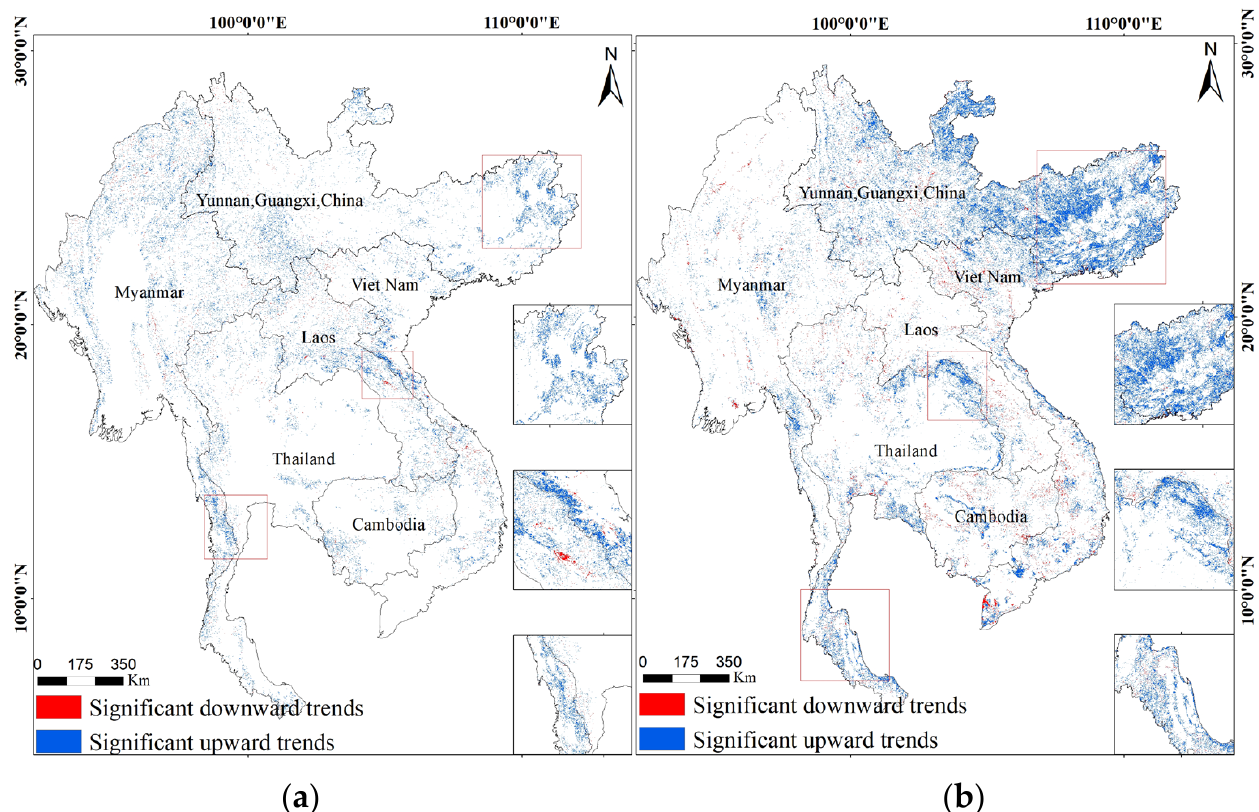
Figure 4. Significant trends in EVI of forests and grasslands without type change: ( a ) significant trends in EVI of forests; ( b ) significant trends in EVI of grasslands.